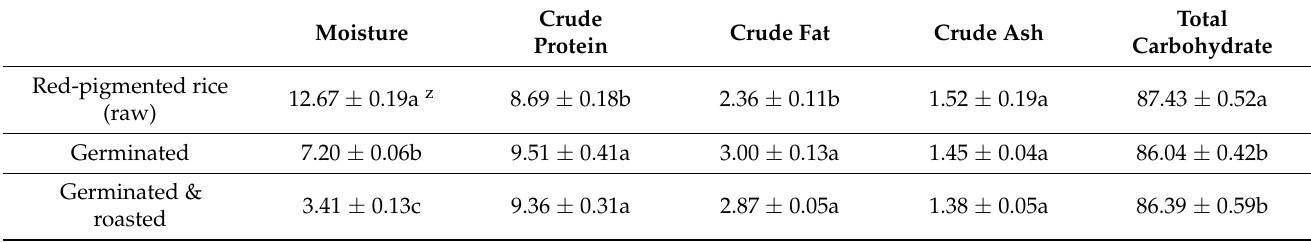
Table 1. Effects of germination and roasting on proximate composition (%) of red-pigmented rice. Crude Moisture Crude Fat Crude Ash Protein